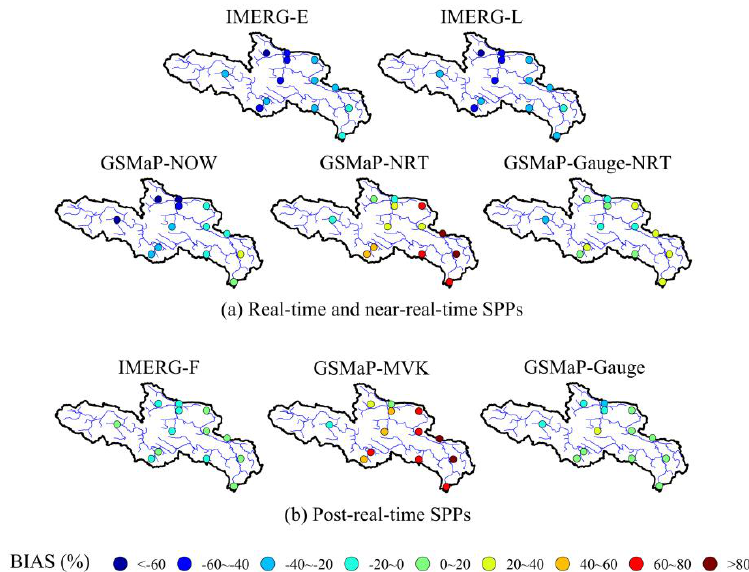
Figure 8. Spatial distribution of BIAS values at the hourly scale for all eight SPPs: ( a ) Real-time and near-real-time SPPs and ( b ) Post-real-time SPPs.